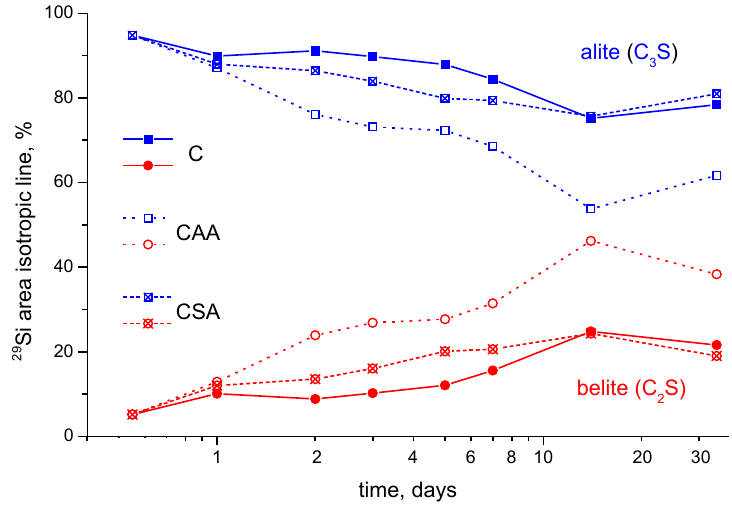
Figure 7. Time-evolution (in logarithmic scale) of the relative integrated areas of the isotropic component of calcium silicates (belite (C 2 S, blue markers) and alite (C 3 S, red markers)) recognized in the 29 Si NMR spectra of the studied samples ( C (filled points), CAA (empty points) and CSA (crossed points)).